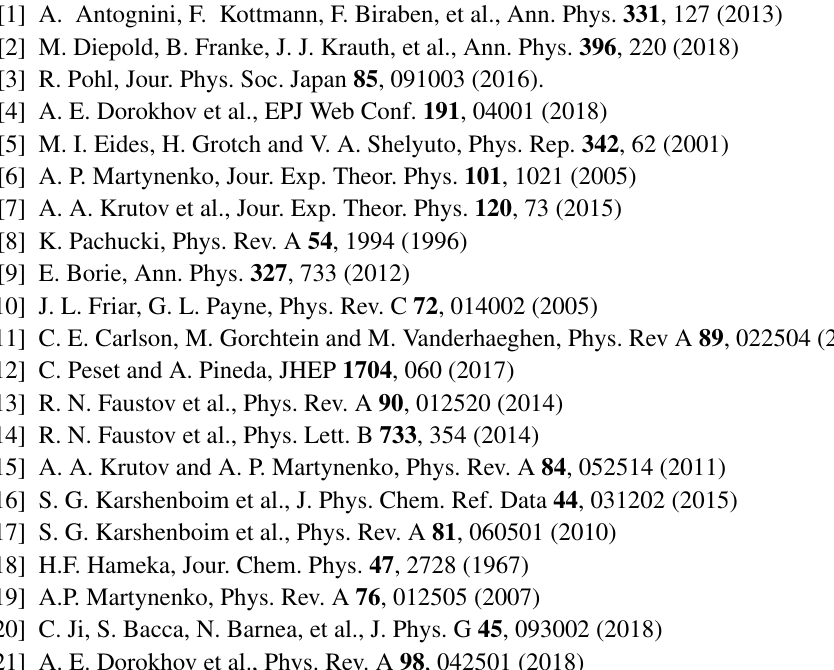
ciated with the electronic vacuum polarization and relativistic e ff ects, nuclear structure, and recoil in the first, second, and third orders of the perturbation theory. New contributions to the particle interaction operator of order α 5 and α 6 obtained in this study are determined by dif- ferent e ff ects. The corrections themselves are presented in the integral form for the S -states, although the integration with respect to coordinates can always be carried out